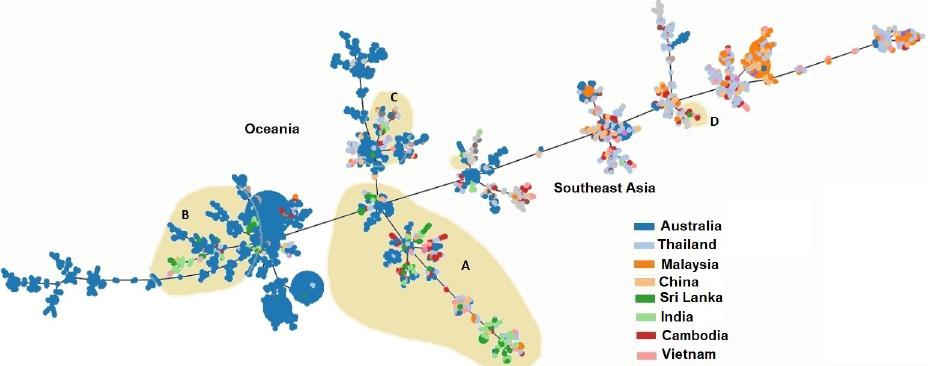
Fig 5. PHYLOVIZ analysis showing the genetic relationship among global collection of sequence types (STs) of Burkholderia pseudomallei reported from Thailand (ash), Malaysia (orange), China (light orange), Sri Lanka (dark green), India (light green), Cambodia (red) and Vietnam (pink). Sri Lankan STs (shaded in beige) clustered in four groups (A, B, C and D). Group A and D clustered with STs from Southeast Asia, group B and C clustered with STs from